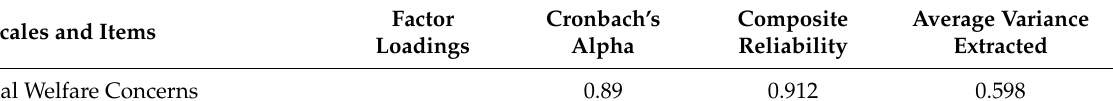
Table 2. Item/scale factor loadings, scale reliabilities, and scale convergent